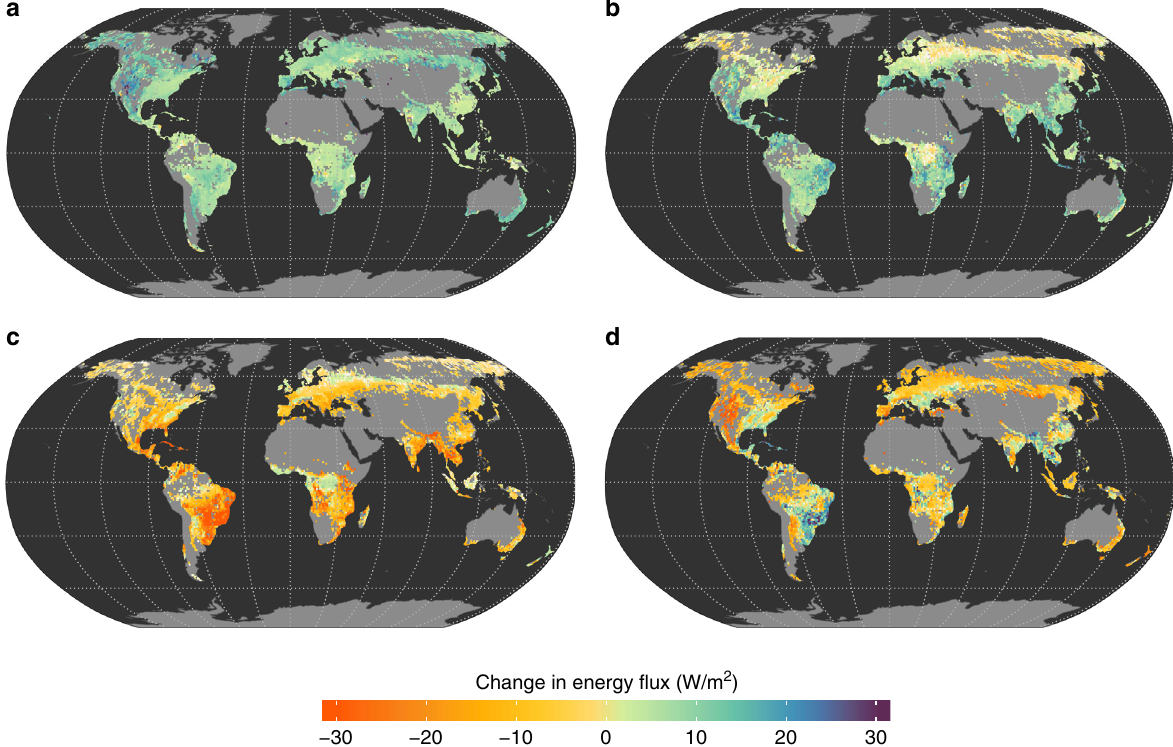
Fig. 2 Potential changes to the local energy balance caused by deforestation. Expected average annual changes are provided for a shortwave re fl ected radiation (SW), b longwave emitted radiation (LW), c latent heat fl ux (LE) and d the combination of sensible and ground heat fl uxes (H+G).